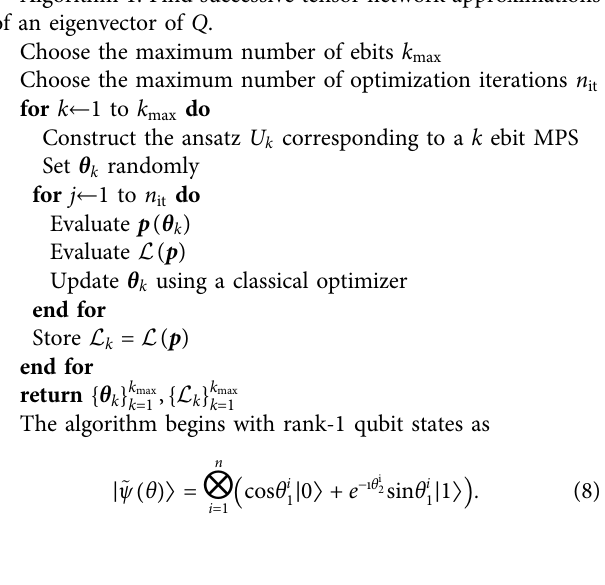
Algorithm 1: Find successive tensor network